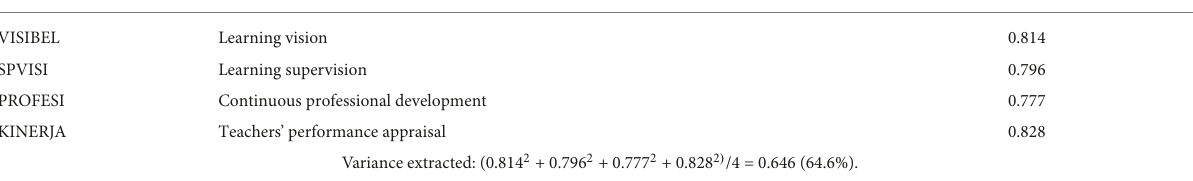
TABLE 4 The loading factor from the dimension to the y-variable is learning leadership.